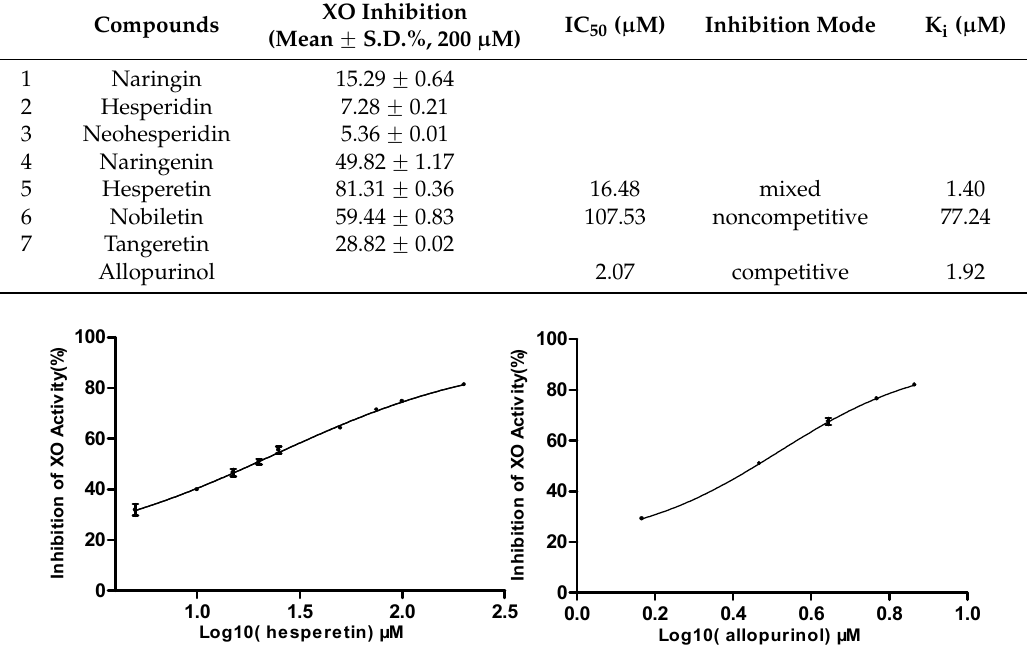
Figure 3. Concentration-dependent inhibition of XO activity by hesperetin and allopurinol. Data represent mean ± standard deviation (S.D.) of triplicate experiments.